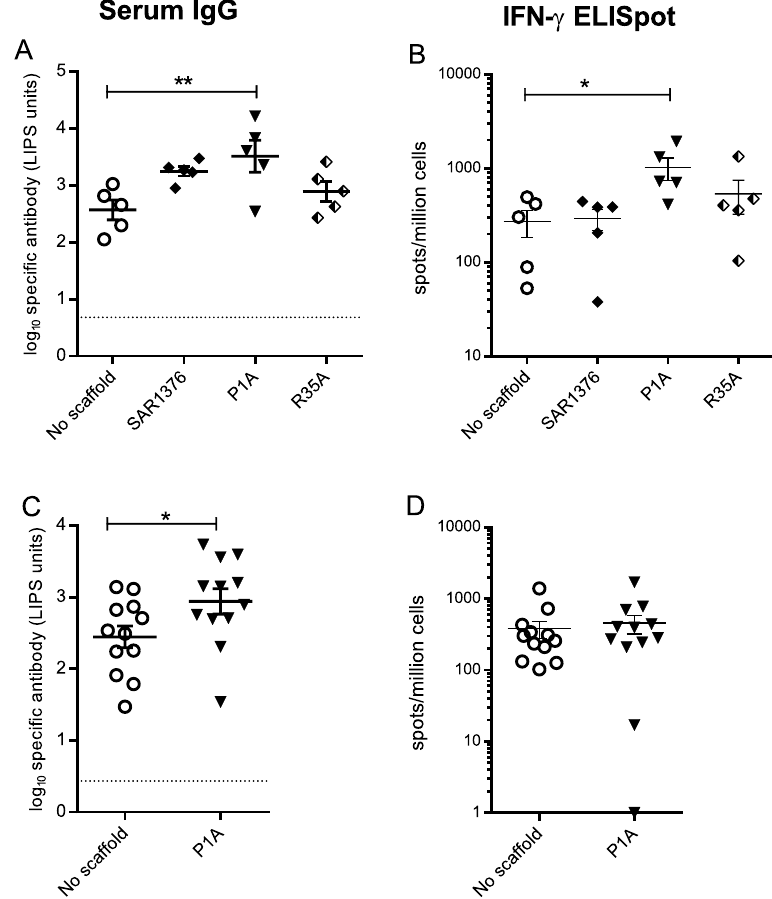
Figure 5. SAR1376 mutant P1A scaffold enhances immune responses to ClfB in BALB/c and CD1 mice. Mice were vaccinated twice with DNA vectors expressing the antigens shown. Antigen specific antibody responses against ClfB in BALB/c (panel A) and CD1 (panel C) mice as measured by LIPS assay, and number of IFN- γ producing T-cells induced by ClfB in BALB/c (panel B) and CD1 (panel D) mice after vaccination with mutant scaffolds fused to the c-terminus of the antigen. Sera were collected 3 weeks post second injection. Each symbol represents a single mouse. Dotted line: threshold for background response. * p < 0.05; ** p <